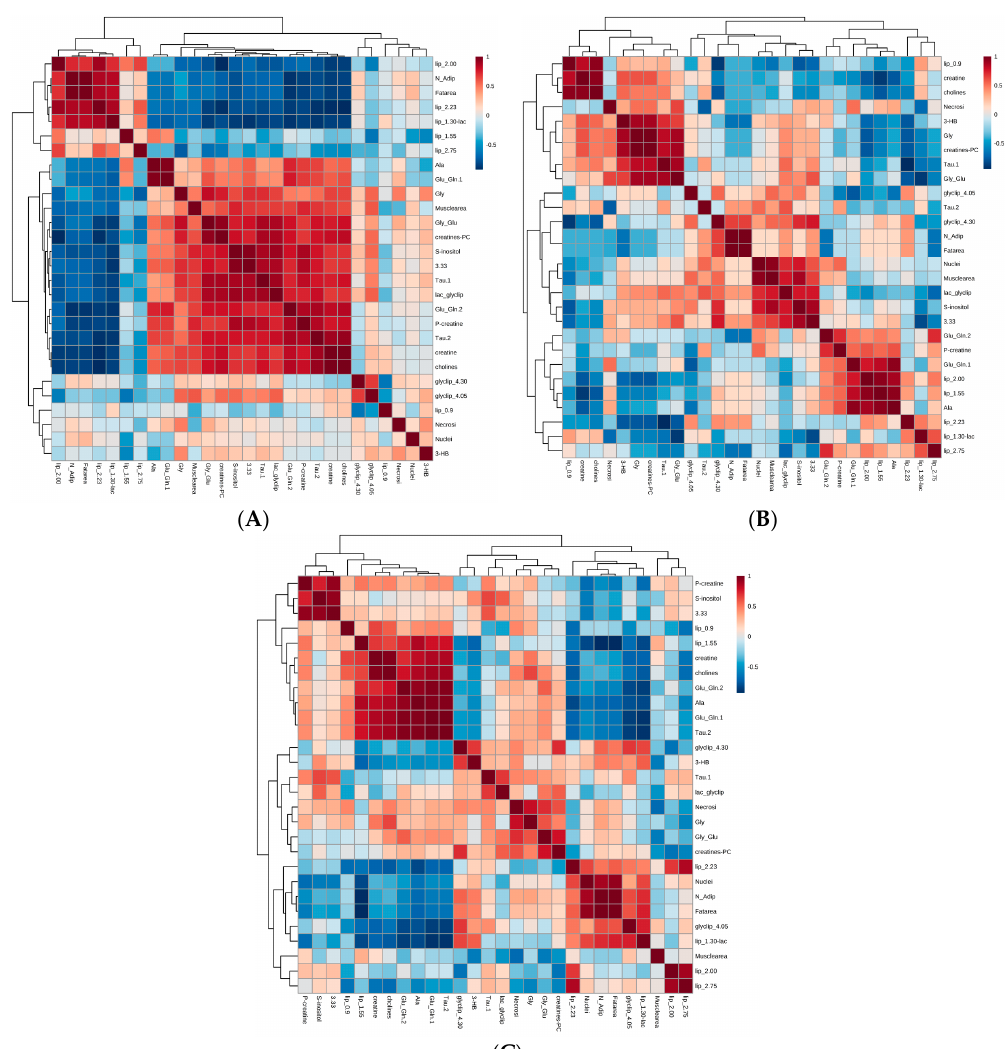
Figure 4. Integrated correlation analysis of histomorphometry and 1 H HR-MAS NMR profiling data. Joint correlation heatmaps consisting of histomorphometry and 1 H HR-MAS NMR profiling datasets (including 5 histomorphometric features and 23 NMR bins/metabolites) obtained considering ( A ) all samples without outliers ( n = 13); ( B ) only muscle samples ( n = 6); ( C ) only tumor samples (including both B and C samples, n = 7). In each matrix histomorphometry data were normalized to total area and scaled to range, while NMR data were normalized to the sum of intensities and Pareto-scaled. NMR bins/metabolites are consistent with Supplementary Table S1. The color of each cell depicts the Spearman-rank correlation coefficients and clusters according to Euclidean distances ( pheatmap library in R) using a thermal scale from anticorrelation ( r = − 1, blue) through uncorrelated ( r = 0, white) to correlated ( r = 1, red). Histomorphometry and NMR data are explicitly labeled on the bottom and on the right of the symmetric matrix, respectively. On the top and on the left of the matrices, dendrograms of the clustering are shown.